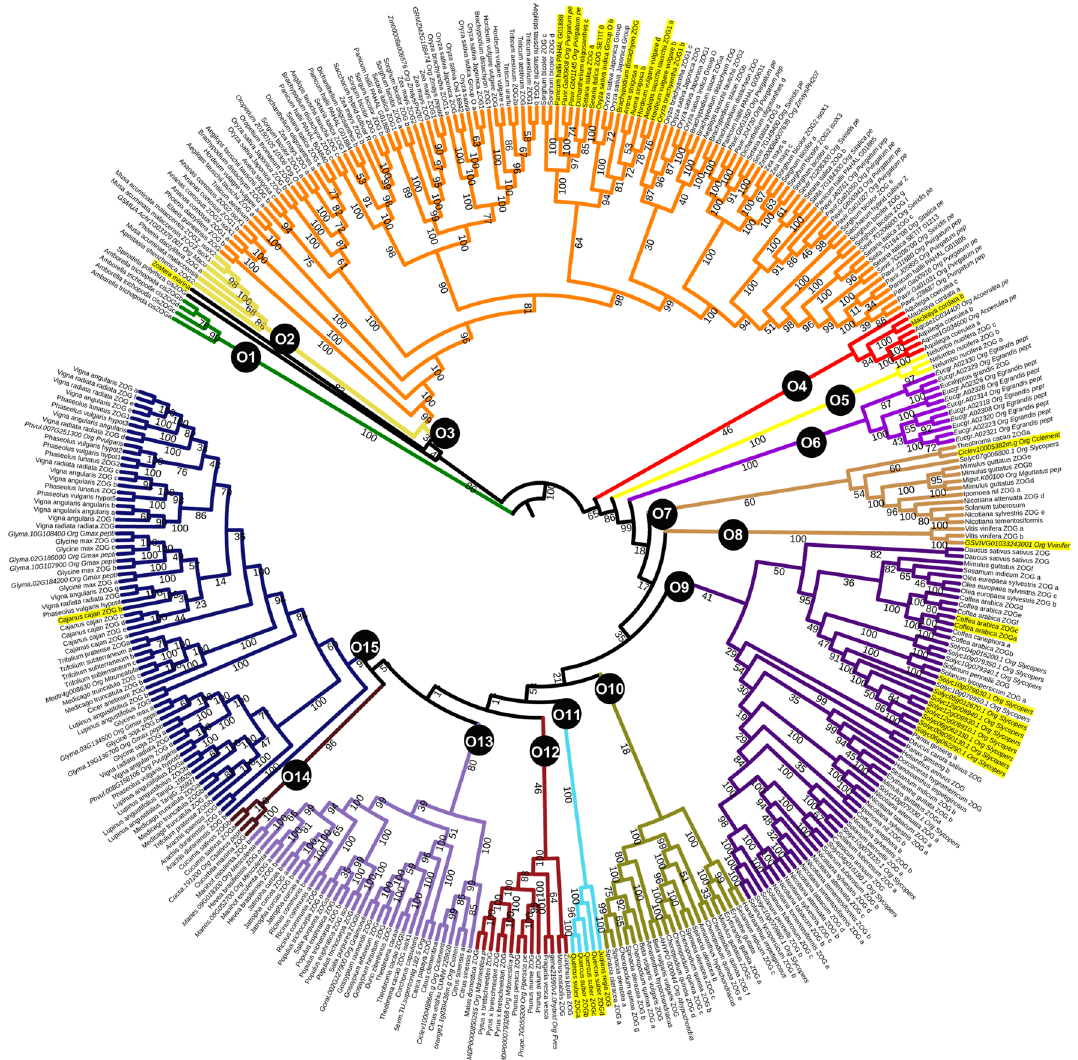
Figure 4. Maximum likelihood phylogenetic tree of cis -zeatin O -glucosyltransferase based on combined data from Phytozome v12 and GenBank. Twenty-seven species were included in 376 sequences with 1719 positions in the final data set. The ML log likelihood is − 112,690.187027. Cis ZOG homologs of Amborella trichopoda were used as outgroups. The tree is divided into fourteen main groups: O1. Amborellaceae, O2. Musaceae, O3. Arecaceae-Bromeliaceae-Musaceae-Orchideaceae-Poaceae, O4. Ranunclulaceae, O5. Myrtaceae, O6. Asteraceae-Apiaceae-Araliaceae-Oleaceae-Phrymaceae-Rubiaceae-Solanaceae, O7. Amaranthaceae, O8. Rutaceae-Phrymaceae, O9. Vitaceae, O10. Moraceae-Rhamnaceae-Rosaceae, O11. Cucurbitaceae, O12. Malvaceae-Euphorbiaceae-Rutaceae, O13. Fabaceae, O14. Nelumbonaceae, O15. Fagaceae. Numbers below branches indicate bootstrap support values > 50%. Yellow boxes refer to sequences without a two highly conserved residues, histidine and serine, at positions 41 and 42 in PSPGD domain, italics indicate sequences from